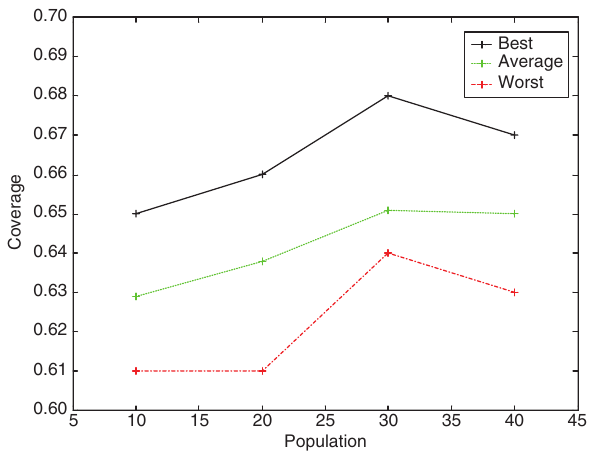
Figure 3: Three Kinds of the Line Chart of the Coverage Rate with the Population Size